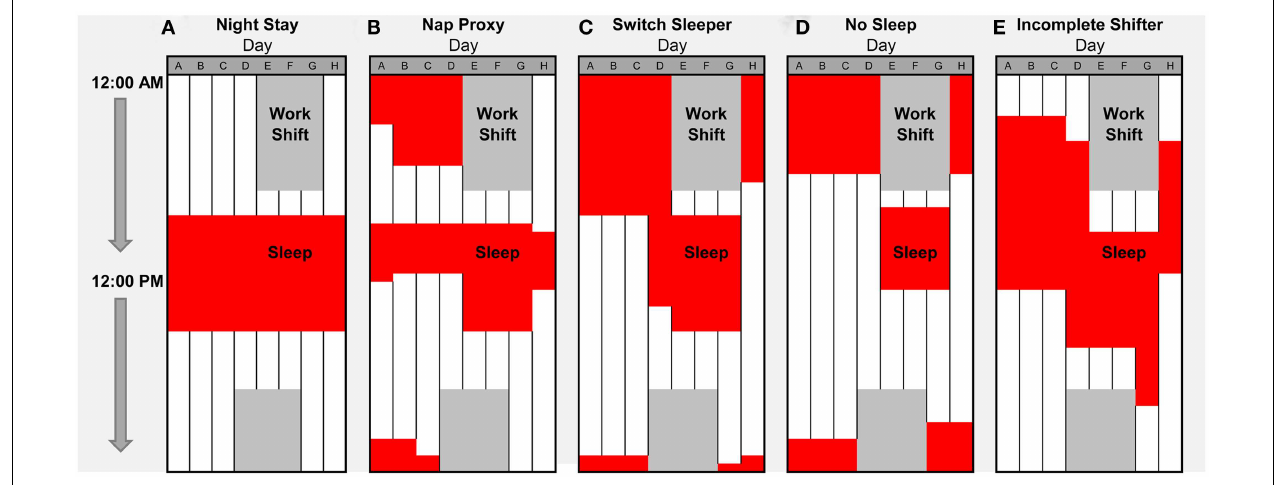
days-off (and percentage among night shift workers) were: (A) Night Stay (2.4%); (B) Nap Proxy (12.2%); (C) Switch Sleeper (49.2%); (D) No Sleep (24.3%); and (E) Incomplete Switcher (11.9%). Red indicates sleep times and dark gray indicates night shift schedule from 7:00 p.m. to 7:00 a.m. on Days D–G. Surprisingly, ∼ 1 out of 4 night shift nurses chose to switch between days and nights via a > 24-h sleep deprivation period (the No Sleep